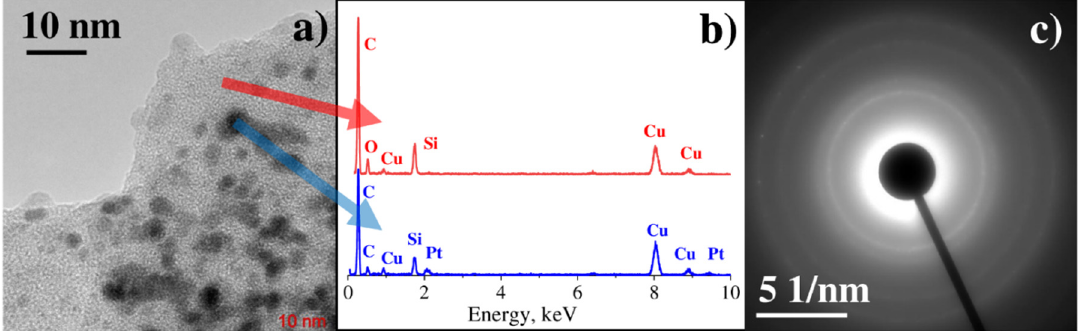
Figure 6. ( a ) BF TEM image, ( b ) EDX spectrum from single nanoparticle and spectrum from the matrix, ( c ) electron diffraction pattern.